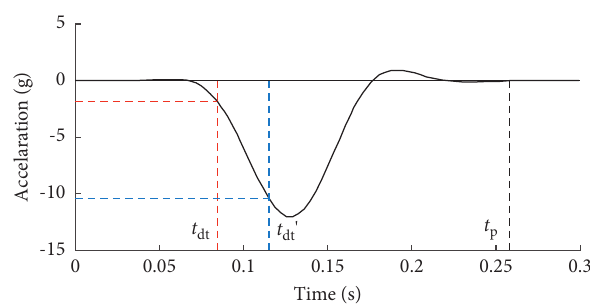
Figure 7: Function of discrimination threshold.